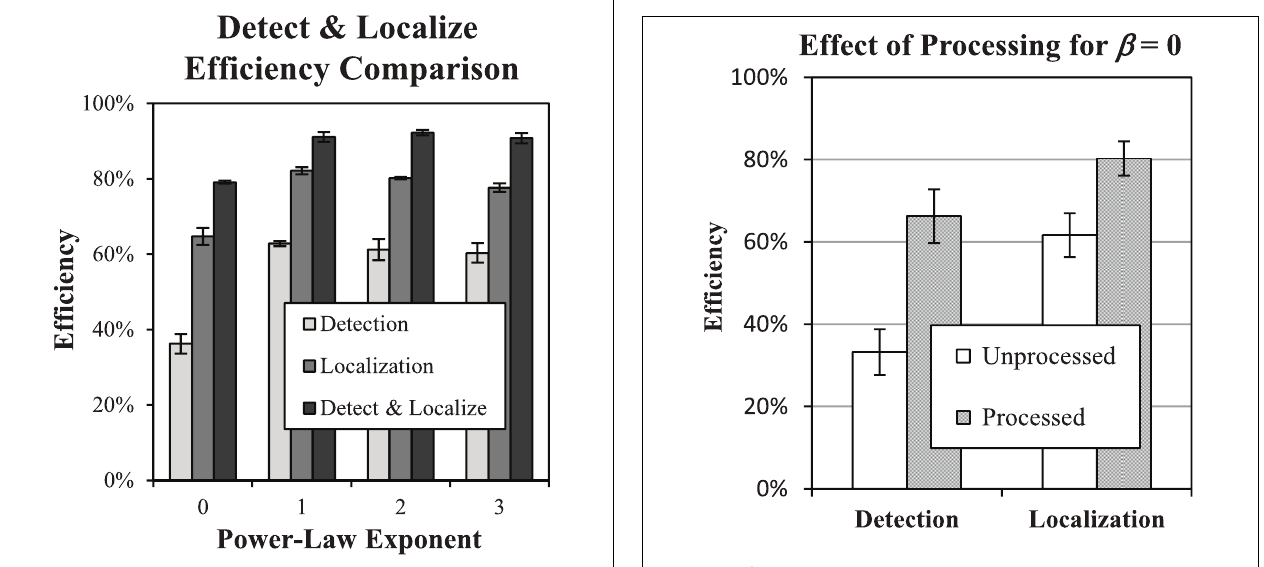
FIGURE 9 | Detect and localize efficiency. The plot shows detect-and-localize efficiency compared to detection efficiency and localization efficiency for each power-law background. Error bars are ± 1 s.e. Small differences with Figure 8 (detection efficiency and localization efficiency) are due to limiting the averages to the three subjects that participated in the D&L study.